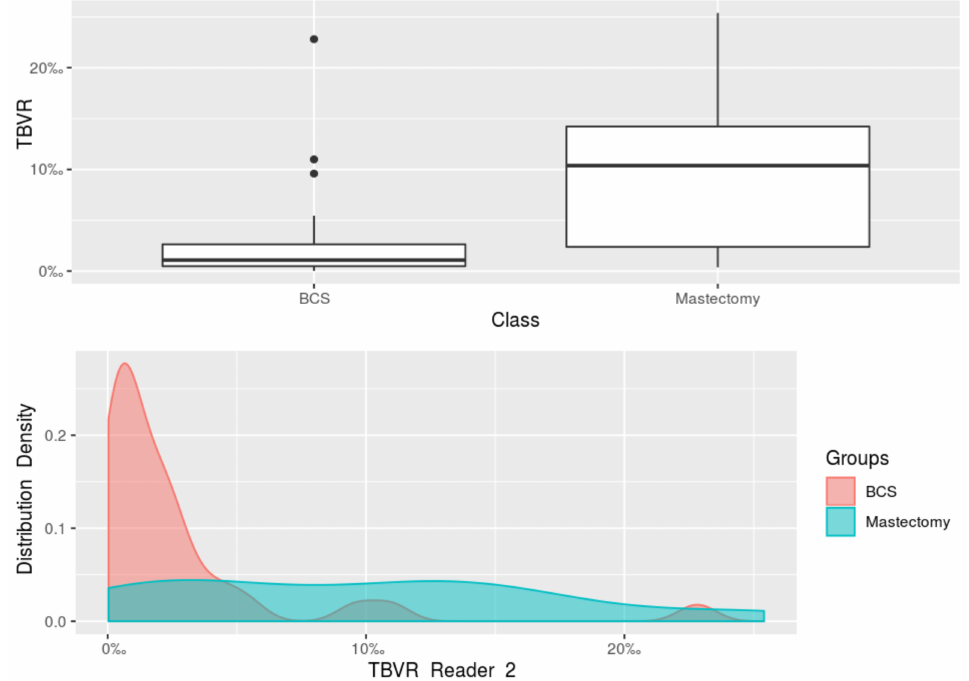
Figure 5. Boxplot and density plot for the comparison of the tumour-to-breast volume ratio obtained from Reader 2’s segmentations of MRI images of the women undergoing breast-conserving surgery and of the women undergoing mastectomy. BCS, breast-conserving surgery; TBVR, tumour-to-breast volume